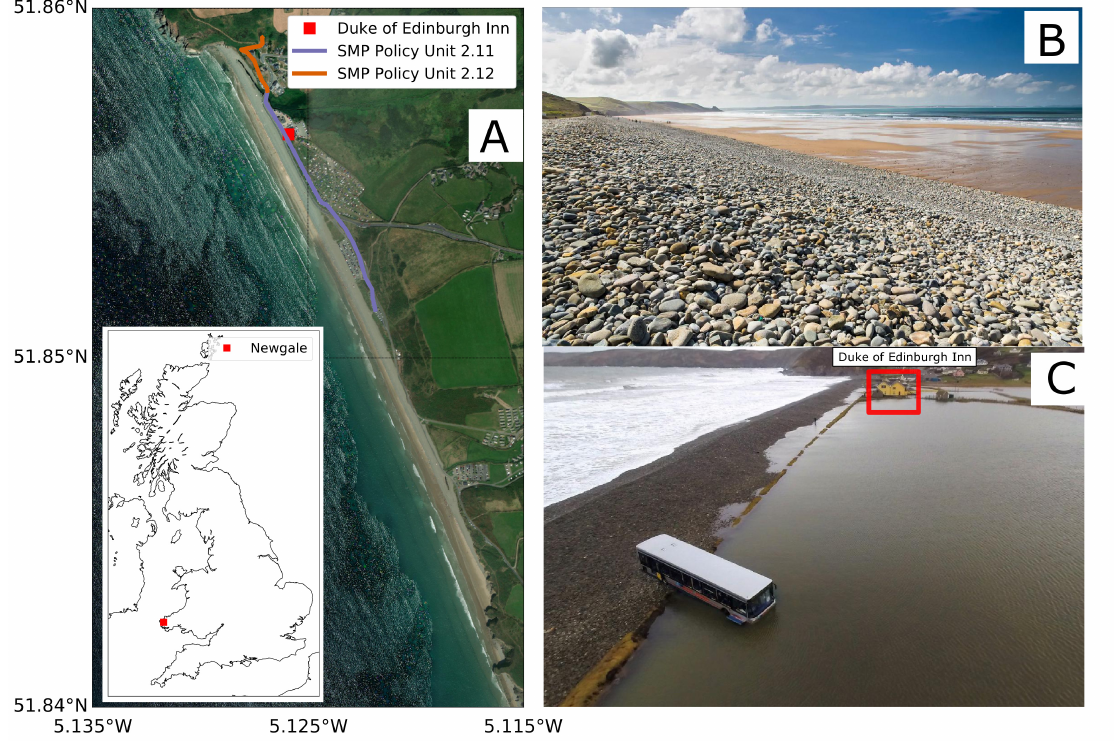
Figure 1. ( A ) Aerial view of Newgale, its location within the U.K. and the SMP2 policy units for the village [27,28], ( B ) the gravel barrier and intertidal sandy foreshore at Newgale looking towards the south-west [29] and ( C ) the aftermath of the January 2014 storm [30]. The Duke of Edinburgh Inn is shown on ( A , C ) to assist